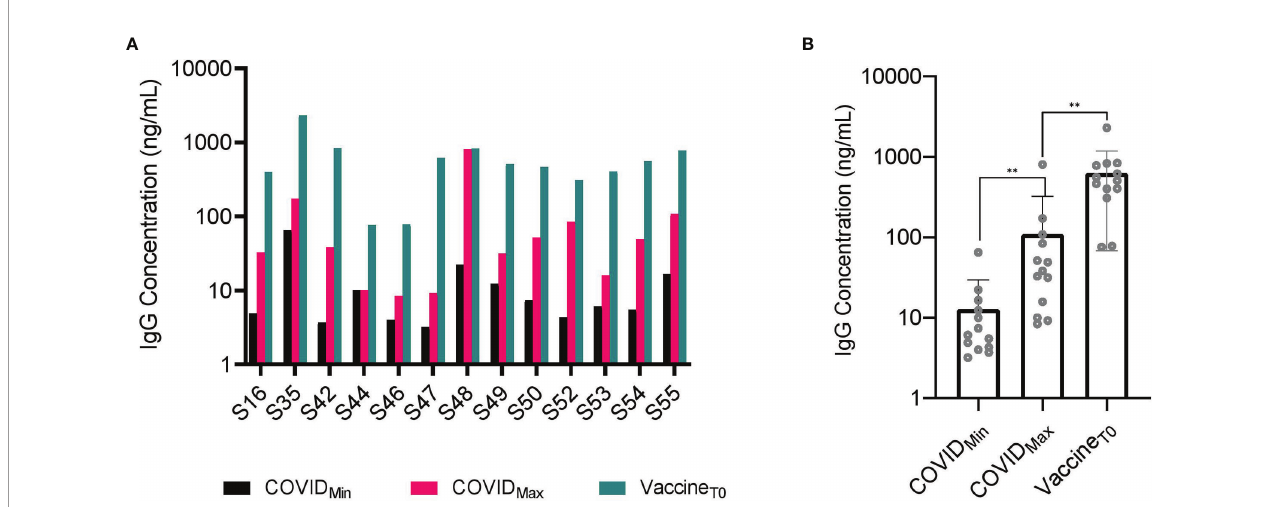
FIGURE 3 | Vaccinated individuals experienced a signi fi cantly higher concentration of SARS-CoV-2 IgG antibodies in oral mucosal fl uid than that prompted by viral infection. (A) SARS-CoV-2 IgG antibody concentration in fourteen (n = 14) individuals who received vaccination following infection. All 14 individuals experienced a signi fi cant (p-value < 0.001) increase in SARS-CoV-2 IgG antibody concentration following vaccination by paired two sample t-test. (B) A comparison between minimum (COVID_Min) and maximum antibody (COVID_Max) concentration post infection with antibody concentration post vaccination (Vaccine T0) reveals a statistically signi fi cant increase by paired two-sample t-test (p-value <0.001). Even compared to the highest concentration of post infection SARS-CoV-2 antibodies in these individuals at an average concentration (107 +/-206 ng/mL), the average concentration of post vaccination SARS-CoV-2 antibodies (626 +/- 537 ng/mL) was signi fi cantly higher. **p-value <